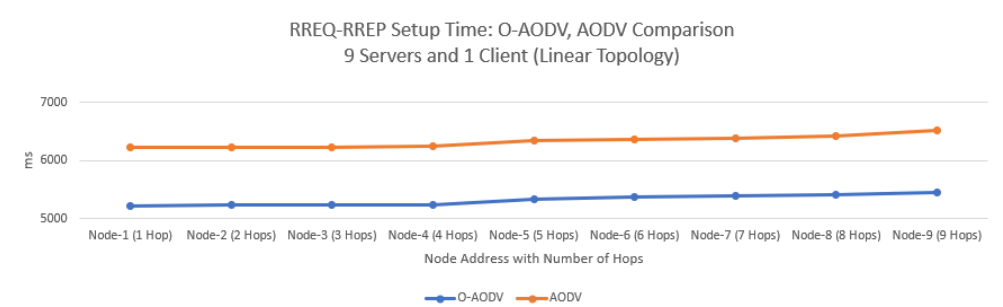
Figure 11. RREQ-RREP setup time: O-AODV and AODV comparison.